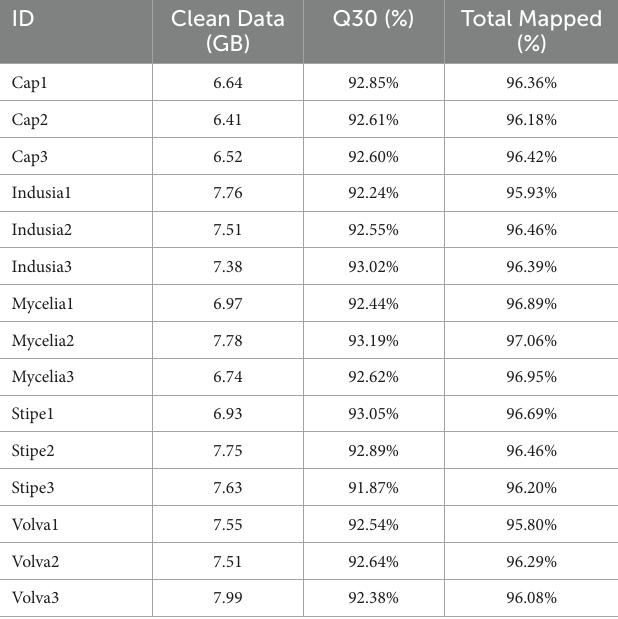
TABLE 2 Statistics of the transcriptome sequences from five DI